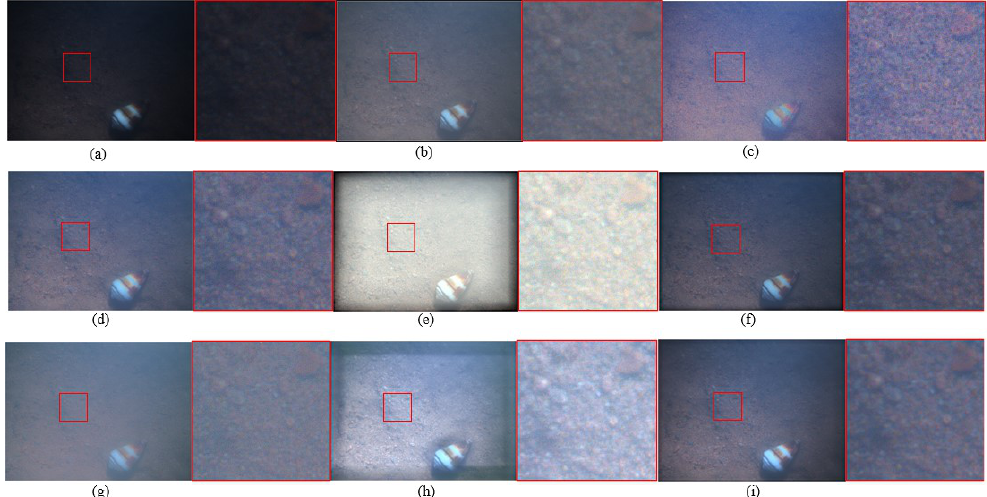
Figure 6. Visual comparison results of different methods in the MUED dataset. ( a ) Input. ( b ) BIMEF.